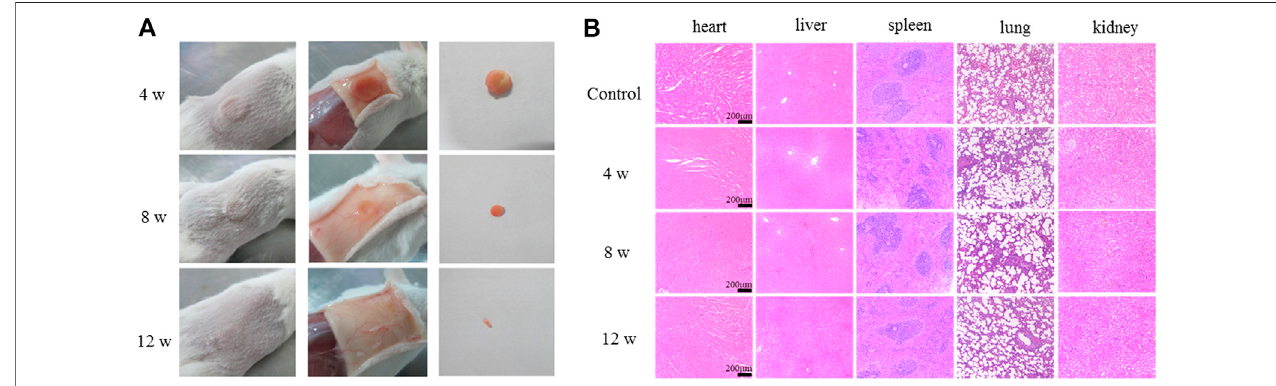
FIGURE 5 | Degradation of TRFS in vivo (A) Study on degradation of TRFS in vivo at 4, 8, and 12 weeks post-implantation into the dorsal subcutaneous tissue of male KM mice (B) HE staining of the heart, liver, spleen, lung, and kidney ( n (cid:1) 10).